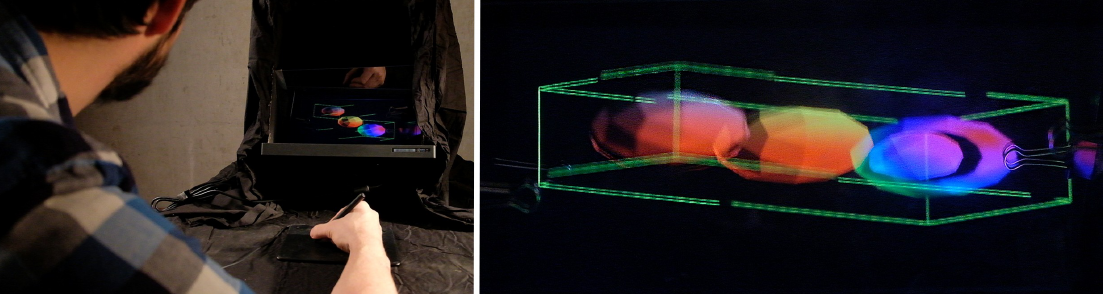
Figure 16. User interacting with a 3D scene sliced into three layers.